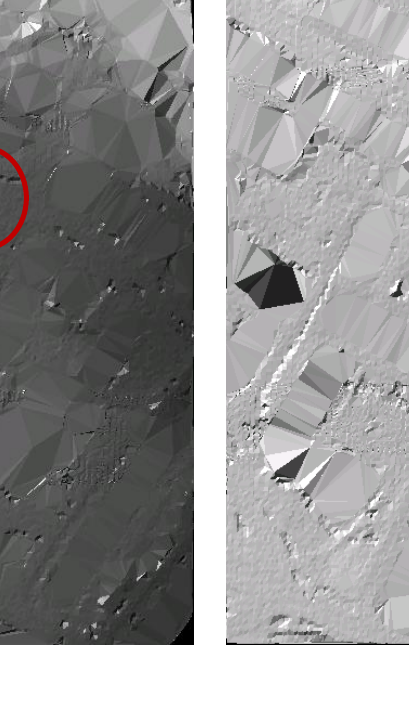
Figure 12. Filtering and results of reference data of Sample 12: ( a ) The DEM generated from the result of the PTD method; ( b ) The DEM generated from the result of the SBF method. Note that the two DEM are